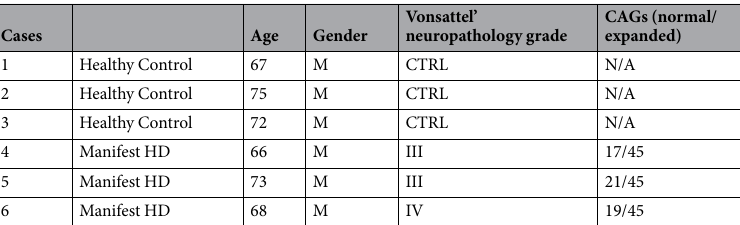
Table 1. Clinical and genetic data of human post-mortem brain